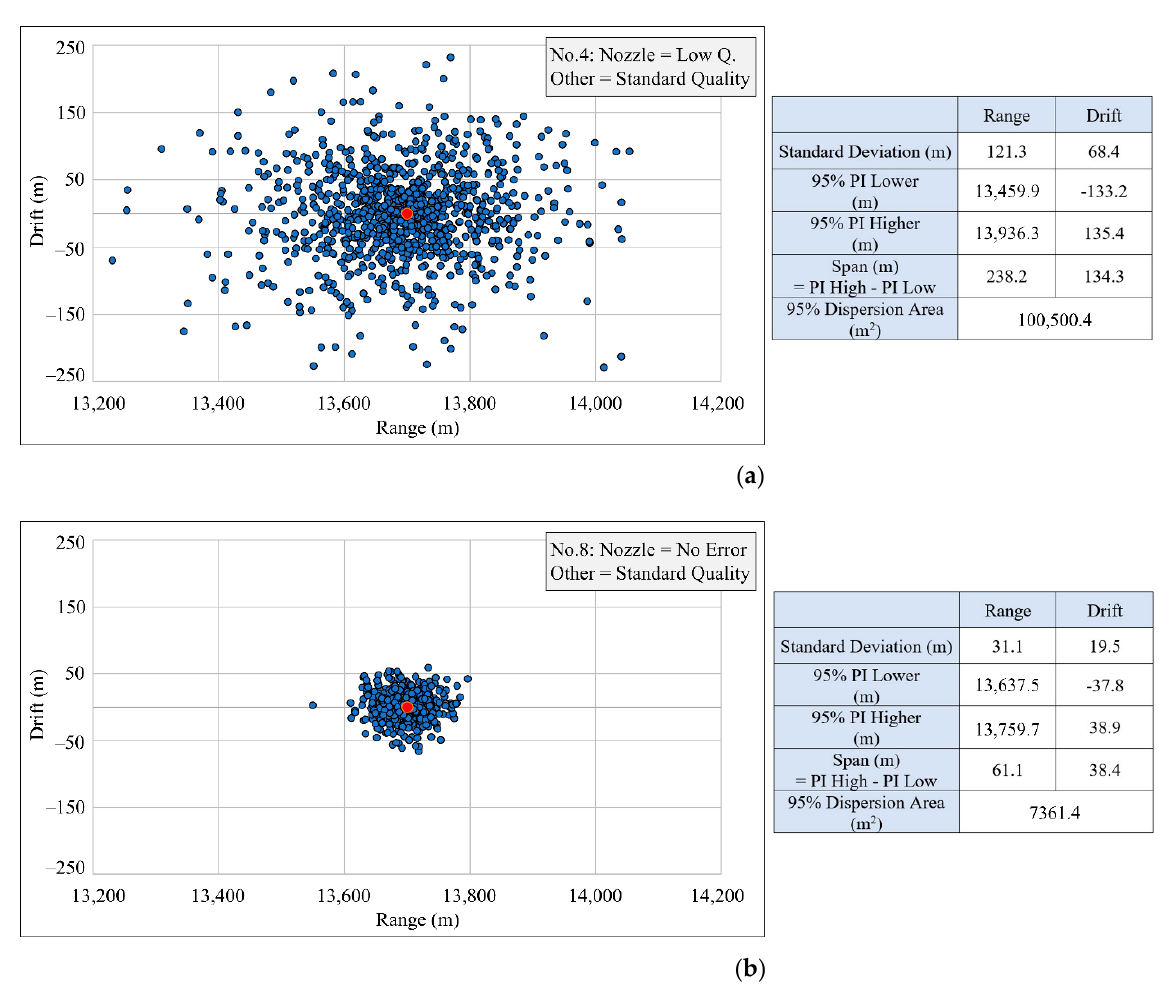
Figure 12. Impact points dispersion with ( a ) and without nozzle error ( b ).